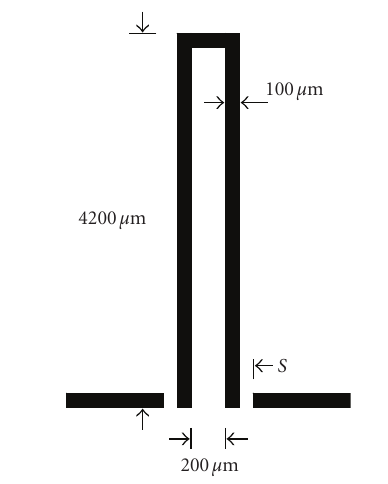
Figure 10: A single-resonator hair-pin filter with capacitance coupling at the input and output.